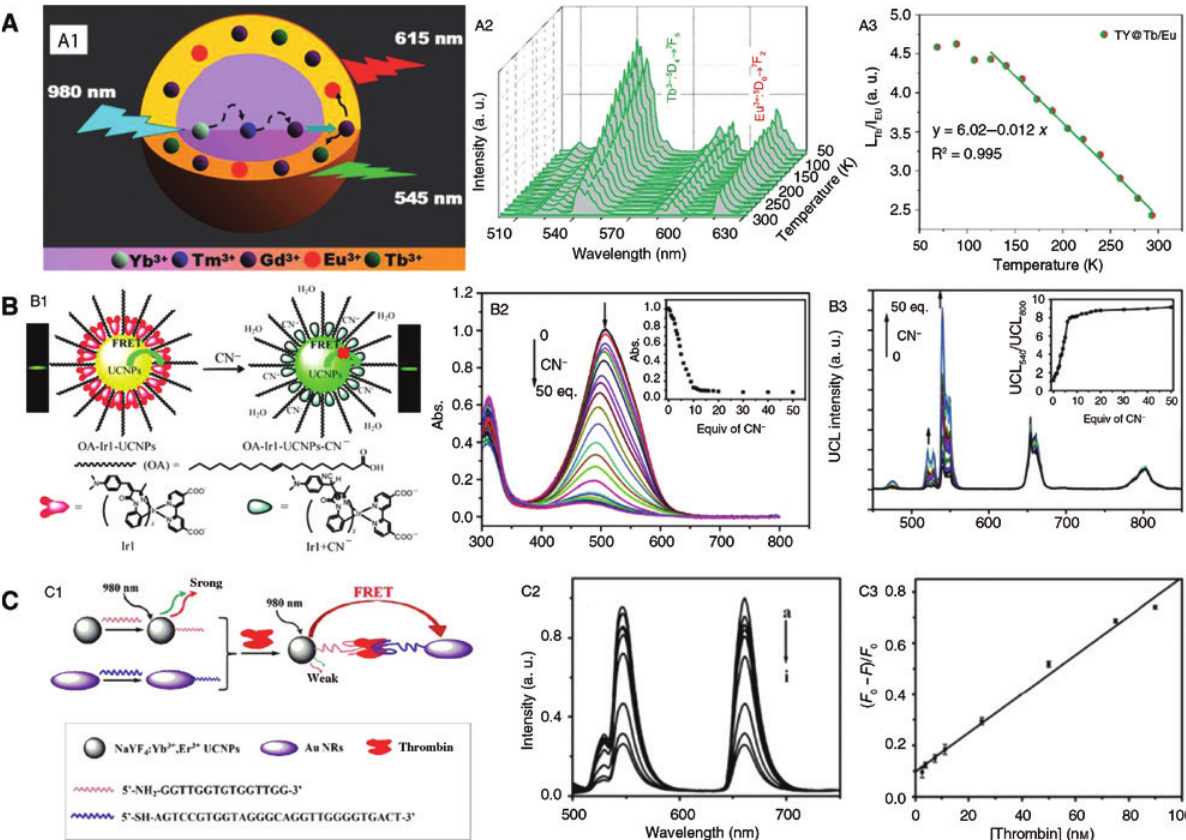
:Yb 3 + , Tm 3 + @NaGdF :Tb 3 + , Eu 3 + core-shell NPs for nanothermometers; 4 4 :Tm 3 + , Yb 3 + (1/49%)@NaGdF :Tb 3 + , Eu 3 + (15/1.5%) core-shell NPs recorded between 50 and 4 4 :20%Yb 3 + , 1.6%Er 3 + , 0.4%Tm 3 + NPs (OA-Ir1-UCNPs) towards cyanide anion 4 / I ) of UCL intensities as a function of CN − concen- 540 800 :Yb 3 + , Er 3 + UCNPs-TBA and AuNRs-TBA (TBA and TBA are aptam- 4 15 29 15 29 after addition of various concentrations of thrombin from 15